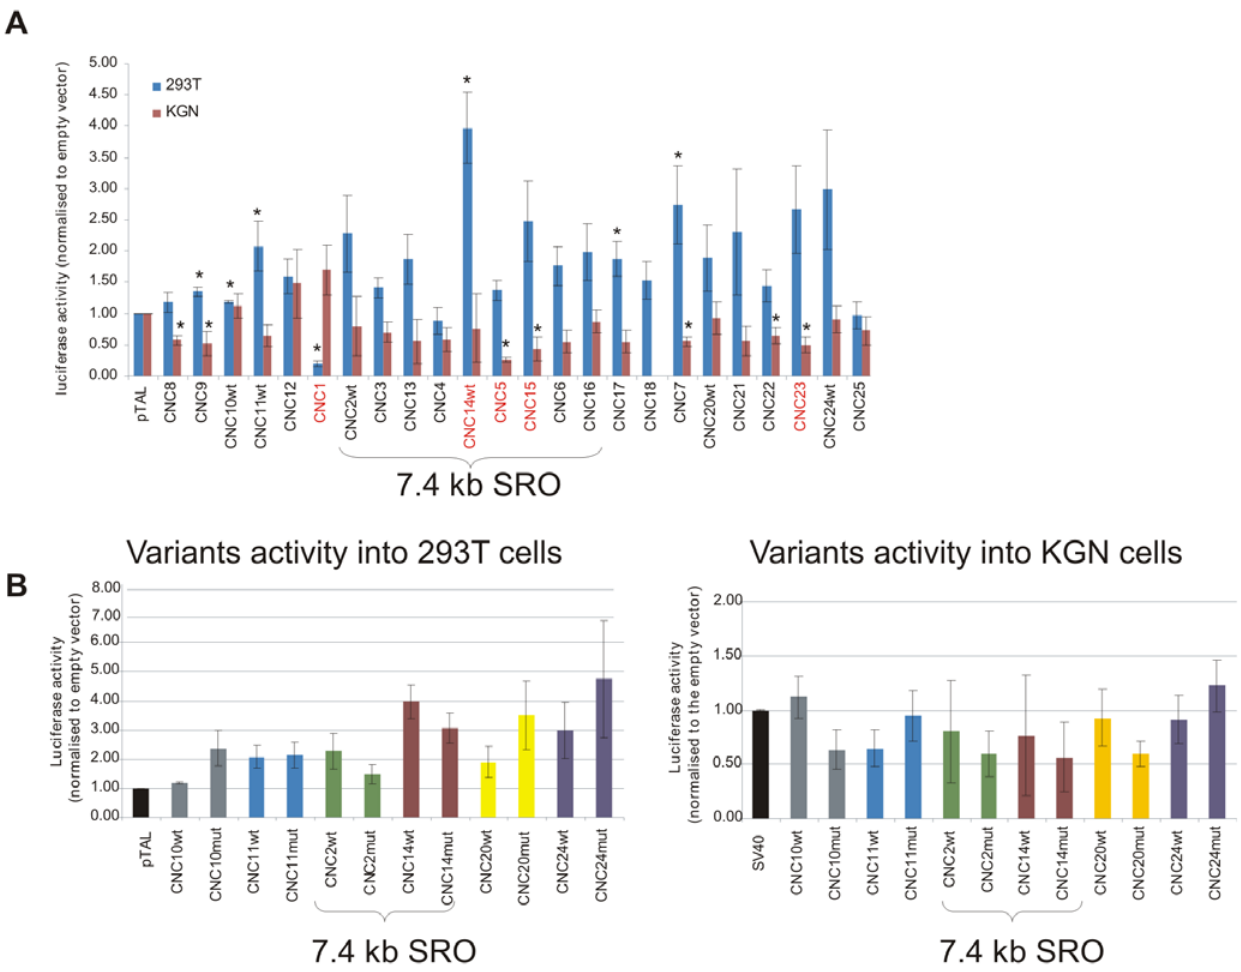
Figure 4. Regulatory activity of wild-type and variant CNCs in FOXL2 expressing and non-expressing cells. The 25 identified CNCs and their putative pathogenic variants were cloned into a luciferase reporter vector and assayed for their regulatory role into expressing KGN and non- expressing 293T (human kidney cells) cells. (A) Bar chart showing the regulatory activity of each independent wild type CNC (CNCwt) in KGN (brown bars) and 293T (blue bars) relative to the basal activity of the empty vector (pTAL). Significant changes (one sample T-test, p value , 0.05) are highlighted by an asterisk. CNCs with a . 2 fold-change in activity between cell lines and a significant p value are shown in red. (B) Bar chart of wtCNCs and variant CNCs (CNCmut) regulatory activity in 293T and KGN cell lines respectively. Each CNC activity is first normalised to the basal activity of the empty vector and significant changes between wt and mut were then assessed by a two-samples T-test. No significant p values were found for any assayed construct (P value , 0.05).